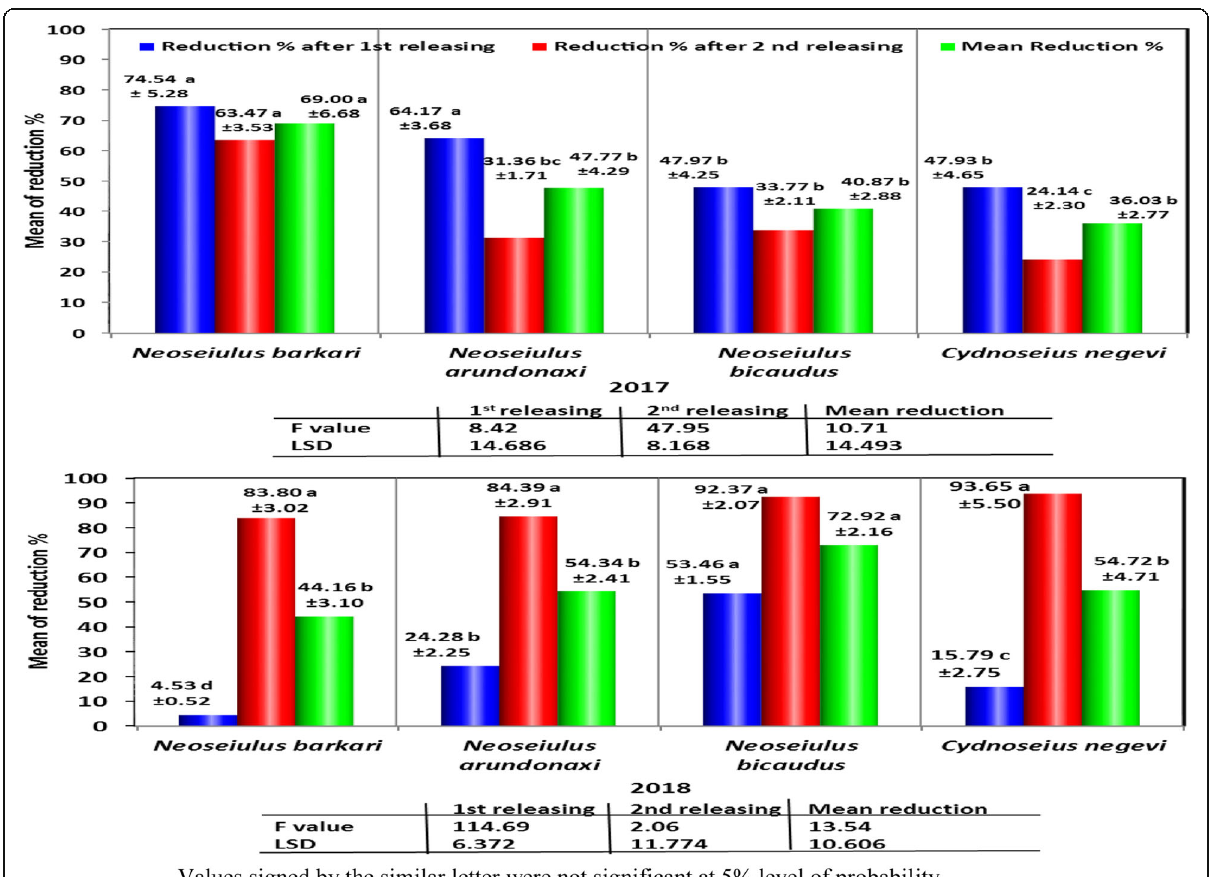
Fig. 1 Reduction percentages of Frankliniella occidentalis adults and nymph stages after releasing the phytoseiid mites on pepper